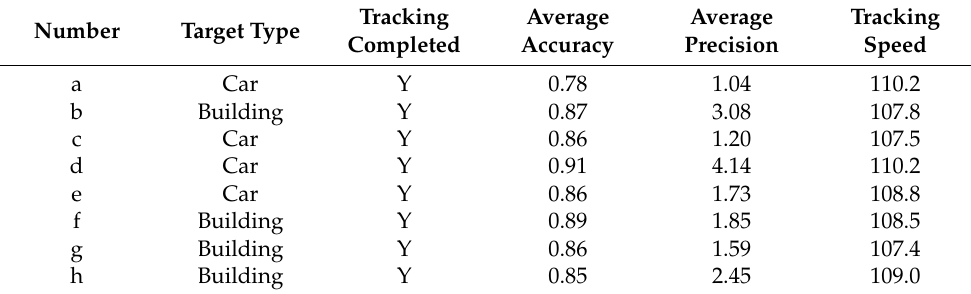
Table 6. Algorithm performance in 8 scenarios.